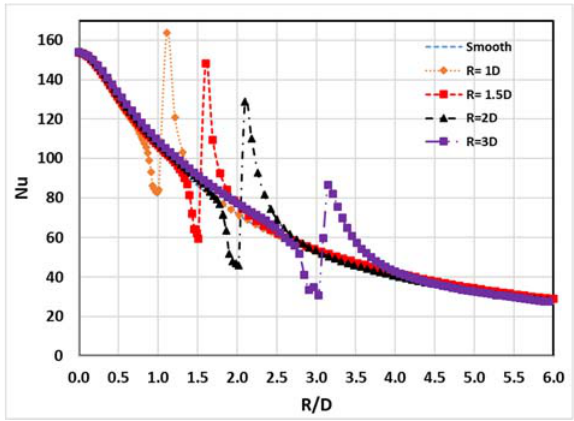
Figure 16. Effect of rib location on local N u